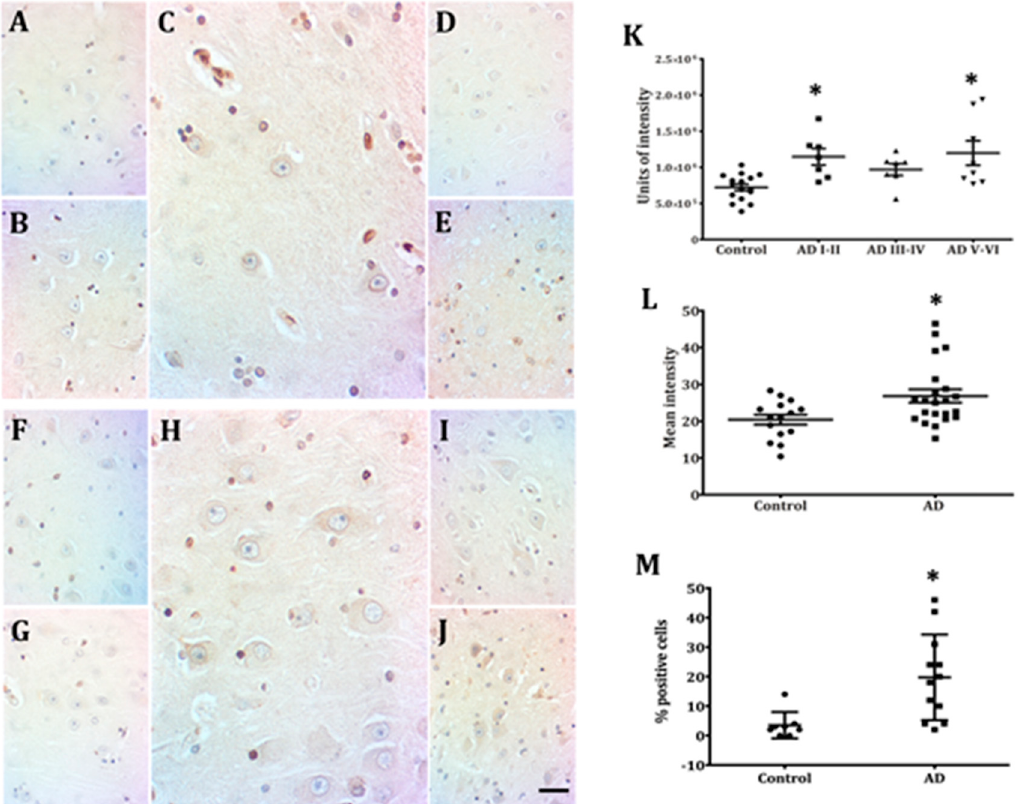
Figure 3. Presence of Lamin A immunopositive pyramidal neurons in CA1 and CA3. Neurons from adult ( A , F ) and elderly ( B , G ) subjects lack immunopositivity to Lamin A. Increased membrane expression of Lamin A characterizes early AD stages ( C , H ) and the presence of immunopositivity continues at late AD stages ( D , E , I , J ), 40X microphotographs, scale bar—10 µm. Quantification of immunopositivity. Significant increases of Lamin A in total intensity ( K ), percentage of positive cells ( L ), and mean intensity ( M ). Each point represents the image analysis of 50 cells per subject in CA1 and CA3 regions. Graphs express mean ± SD, * p < 0.05. See the text for further details of image analysis and statistics.